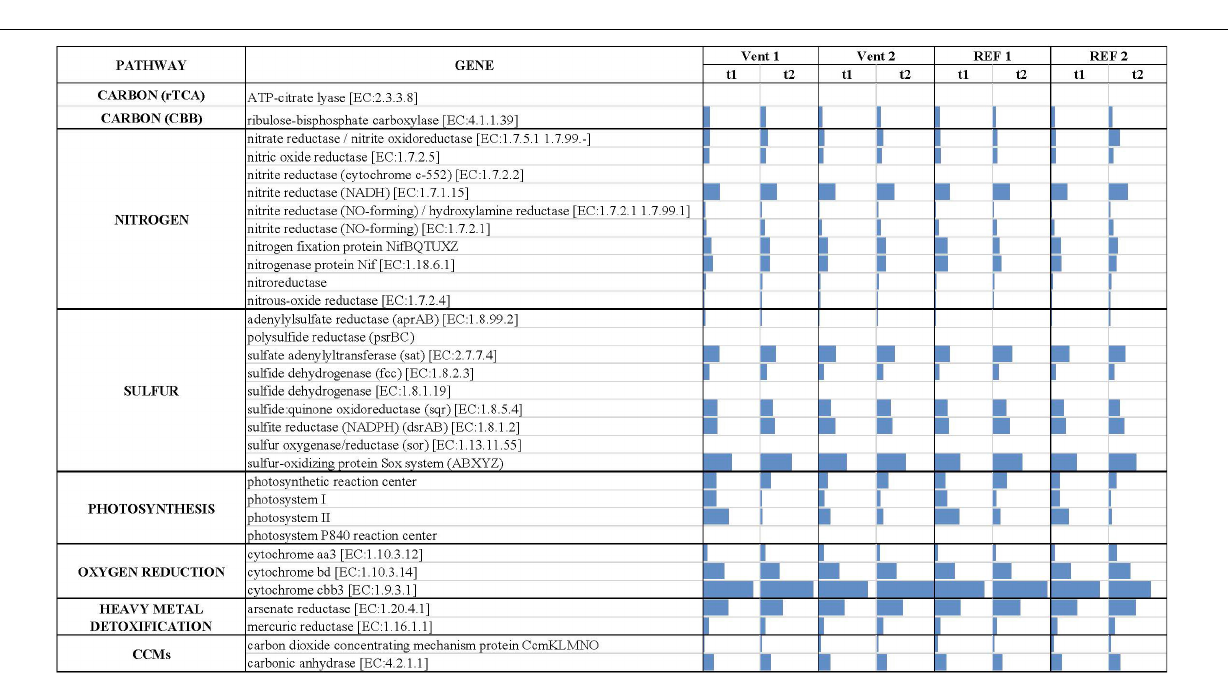
FIGURE 5 | Predicted gene abundance (bars, normalized data) of key metabolic pathways in the biofilms collected from Levante Bay.